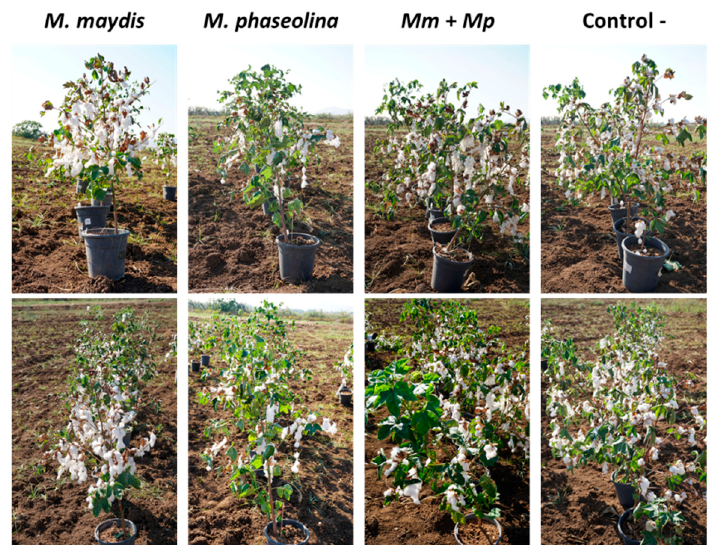
Figure 10. Photograph of the cotton plants under a restricted water regime, in the 2019 experiment (described in Figure 7). The field was photographed 162 DAS. A decreased development of the plants in the M. phaseolina inoculation pots can be seen 。.